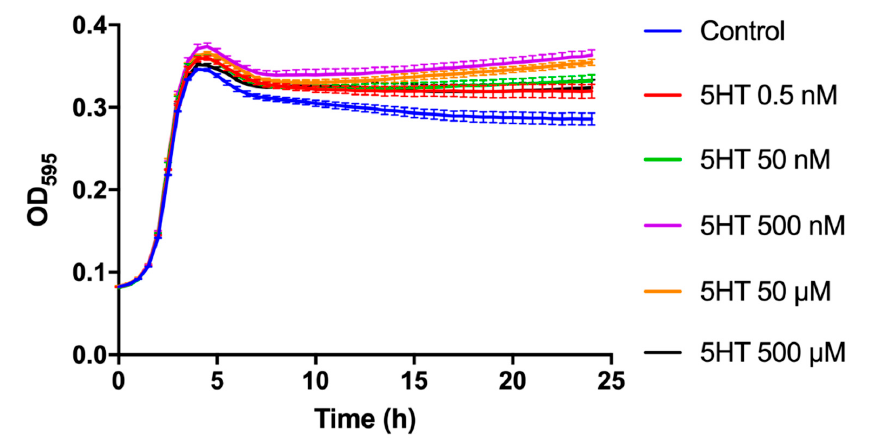
Figure 1. Growth changes. Growth kinetics of 24 h: effect of different concentrations of 5HT (0.5 nM, 50 nM, 500 nM, 50 µM, 500 µM) on the growth of E. faecium NCIMB10415. The effect of the molecule is detectable during the mid and late stationary phase.